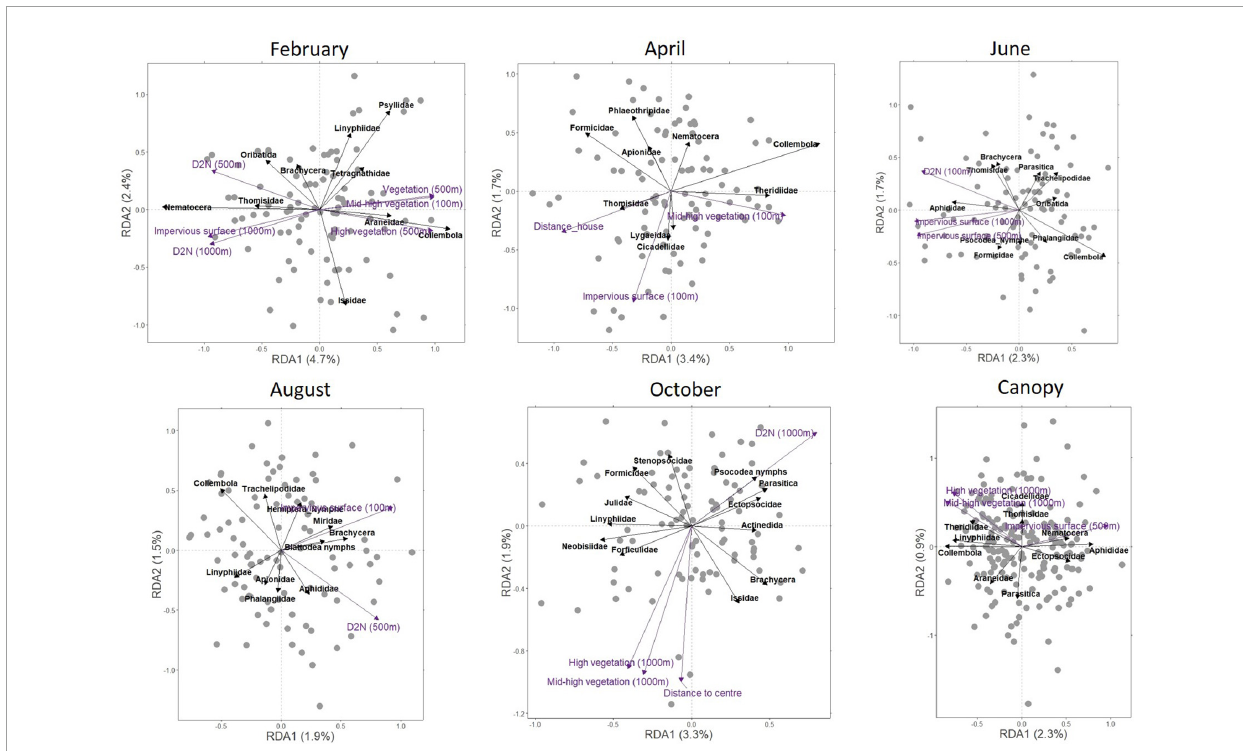
FIGURE5 Redundancy analysis triplots per month and per micro-habitat. The triplots for December and for the micro-habitats “Bush layer” and “Tree bark” are not shown because, in these models, only one RDA component significantly explained arthropod community structuration. The environmental variables significantly explaining differences in arthropod communities between sites are represented by purple vectors. The main taxonomic groups explaining the ordination are highlighted by black